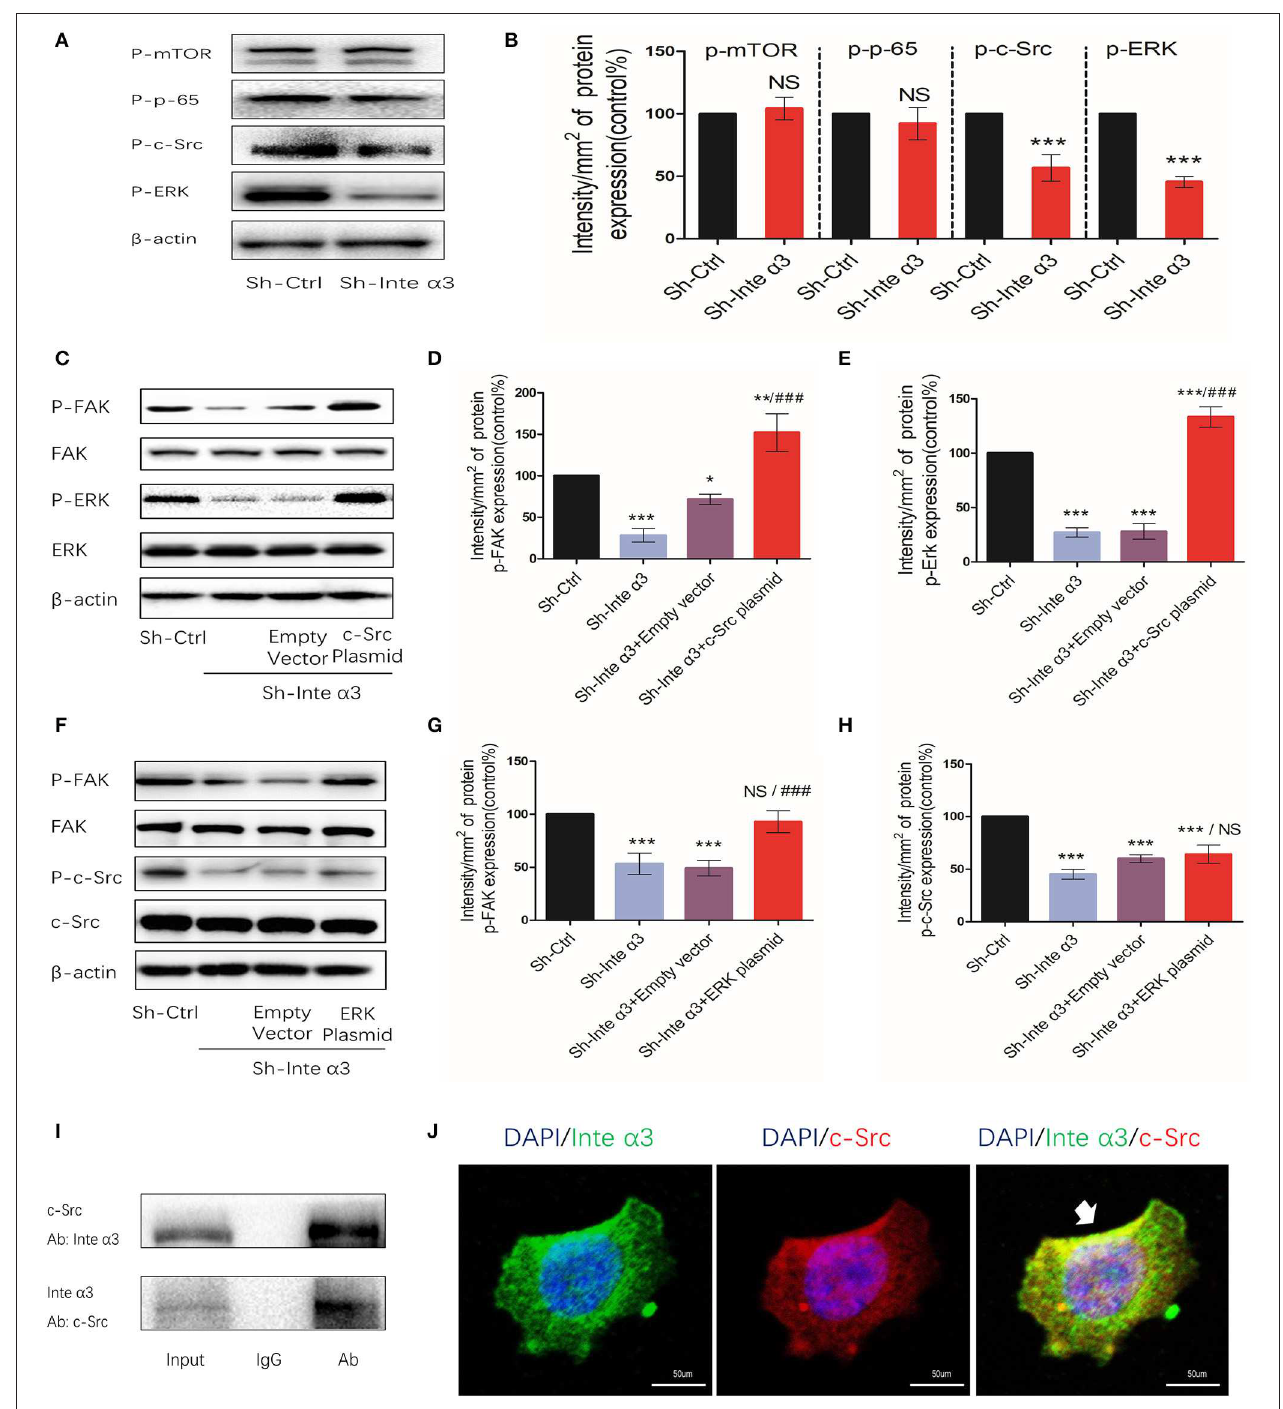
FIGURE 6 | Integrin α 3 activates focal adhesion kinase (FAK) via the c-Src/extracellular signal-regulated protein kinase (ERK) signaling pathway. (A) Phosphorylated mammalian target of rapamycin (mTOR), p-65, c-Src, and ERK were examined through western blotting in the Sh-Ctrl and Sh-Inte α groups; the corresponding quantification of the protein intensity is shown in (B) . (C) The levels of phosphorylated FAK and ERK, as well as total FAK, ERK, and β -actin, were determined via western blotting among the Sh-Ctrl, Sh-Inte α 3, Sh-Inte α 3 + empty vector, and Sh-Inte α 3 + c-Src plasmid groups; the corresponding quantification of p-FAK and p-c-Src protein intensity is presented in (D,E) . (F) Among the Sh-Ctrl, Sh-Inte α 3, Sh-Inte α 3 + empty vector, and Sh-Inte α 3 + ERK plasmid groups, the levels of phosphorylated FAK and c-Src, as well as total FAK, c-Src, and β -actin, were examined through western blotting; the quantification of p-FAK and p-ERK protein intensity is shown in (G,H) . (I) Representative image of co-immunoprecipitation using anti-c-Src or anti-integrin α 3, and subsequent detection of the other protein.